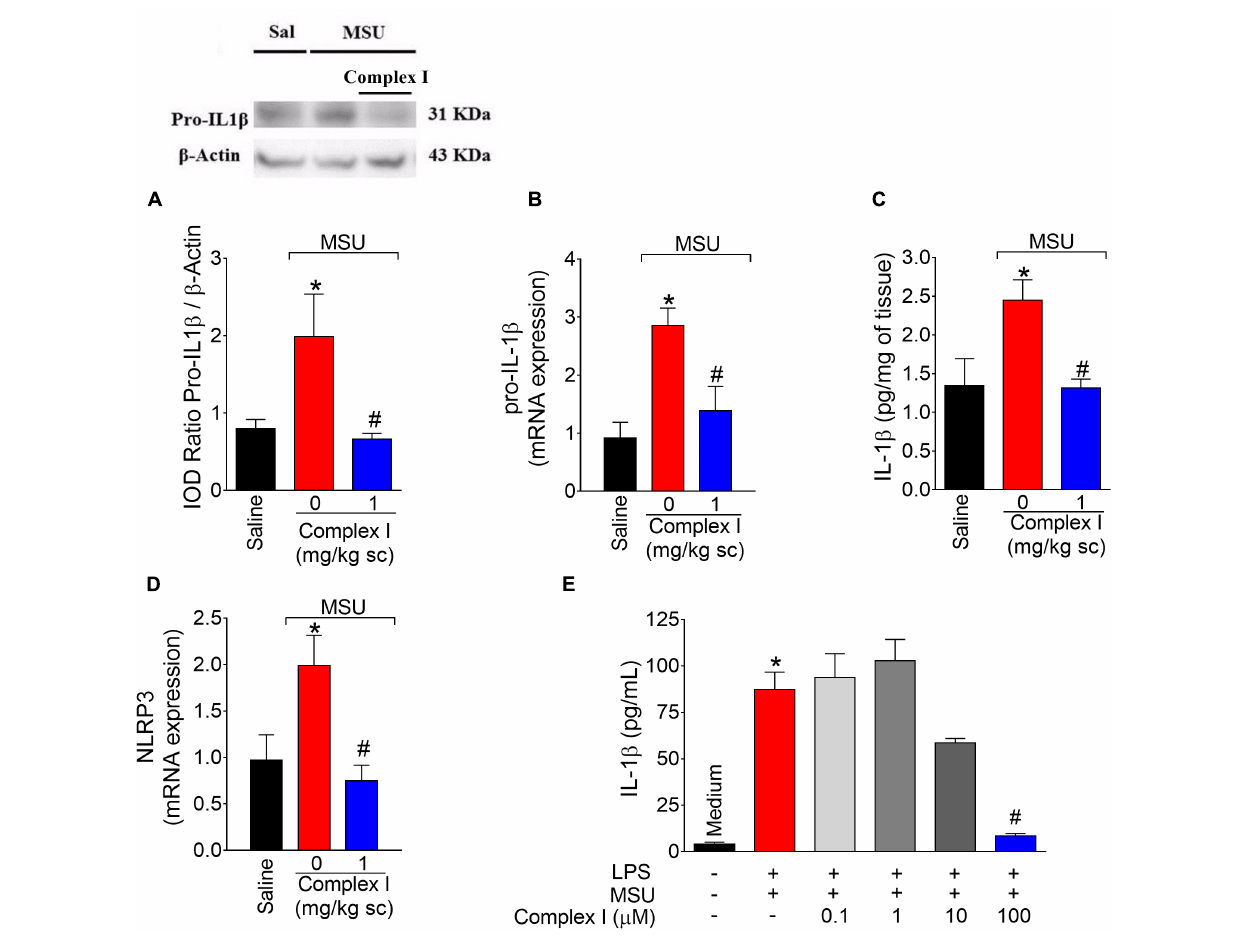
FIGURE 8 | Complex I inhibits MSU-induced IL-1 β up-regulation and inflammasome activation. Mice were treated with complex I (1 mg/kg/saline, s.c.) or vehicle 30 min prior to intra-articular injection of MSU (100 µ g/10 µ l) and after 15 h knee joints samples were collected to measurement of pro-IL-1 β (western blot), (A) ; pro-il-1 β mRNA expression (RT-qPCR), (B) ; IL-1 β (ELISA), (C) and nlrp3 mRNA expression (RT-qPCR), (D) . LPS (500 ng/ml)-primed BMDM were treated with Complex I (0.1, 1, 10, or 100 µ M) 30 min before stimulation with MSU (450 µ g/ml) during 5 h and the IL-1 β concentration (ELISA) in the culture supernatant was measured by ELISA (E) . Results are expressed as mean ± SEM ( n = 6 per group per experiment, representative of two experiments). ∗ p < 0.05 compared to saline group and # p < 0.05 compared to MSU group. One-way ANOVA followed by Tukey’s